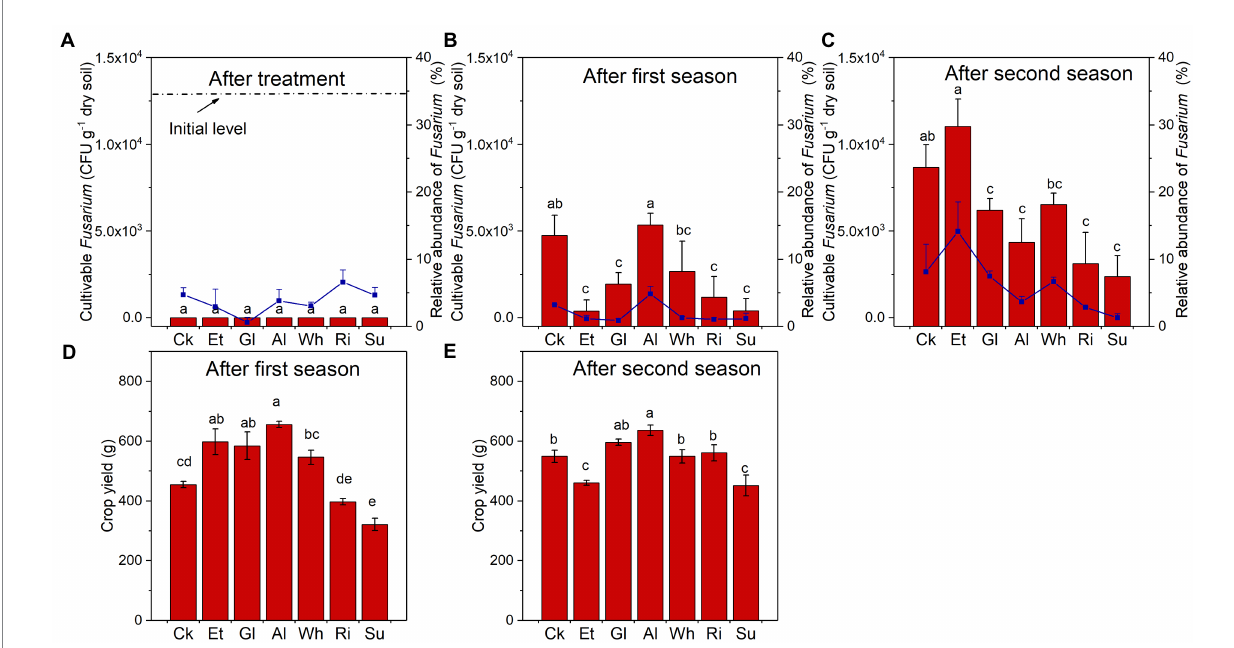
FIGURE 4 (A–C) The number of cultivable Fusarium and relative abundance of Fusarium in soils collected after RSD treatment and two planting seasons. (D,E) Crop yield after the first and second seasons. Different letters indicate significant differences among the soils based on Tukey’s HSD ( p < 0.05). Error bars indicate SDs. Treatment abbreviations are defined in Table